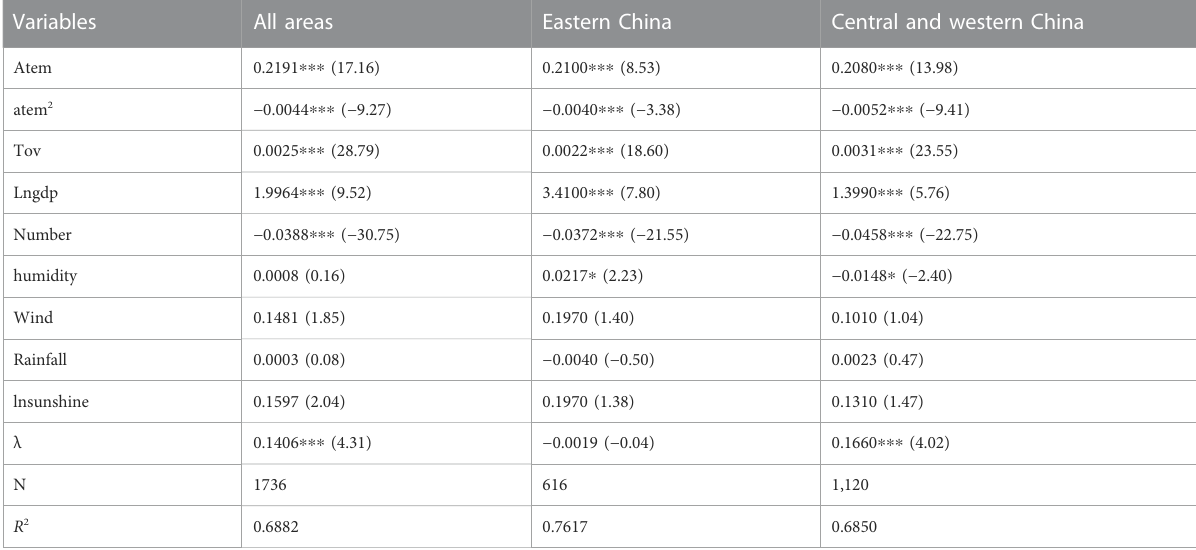
TABLE 4 Results for spatial econometric regression. Variables All